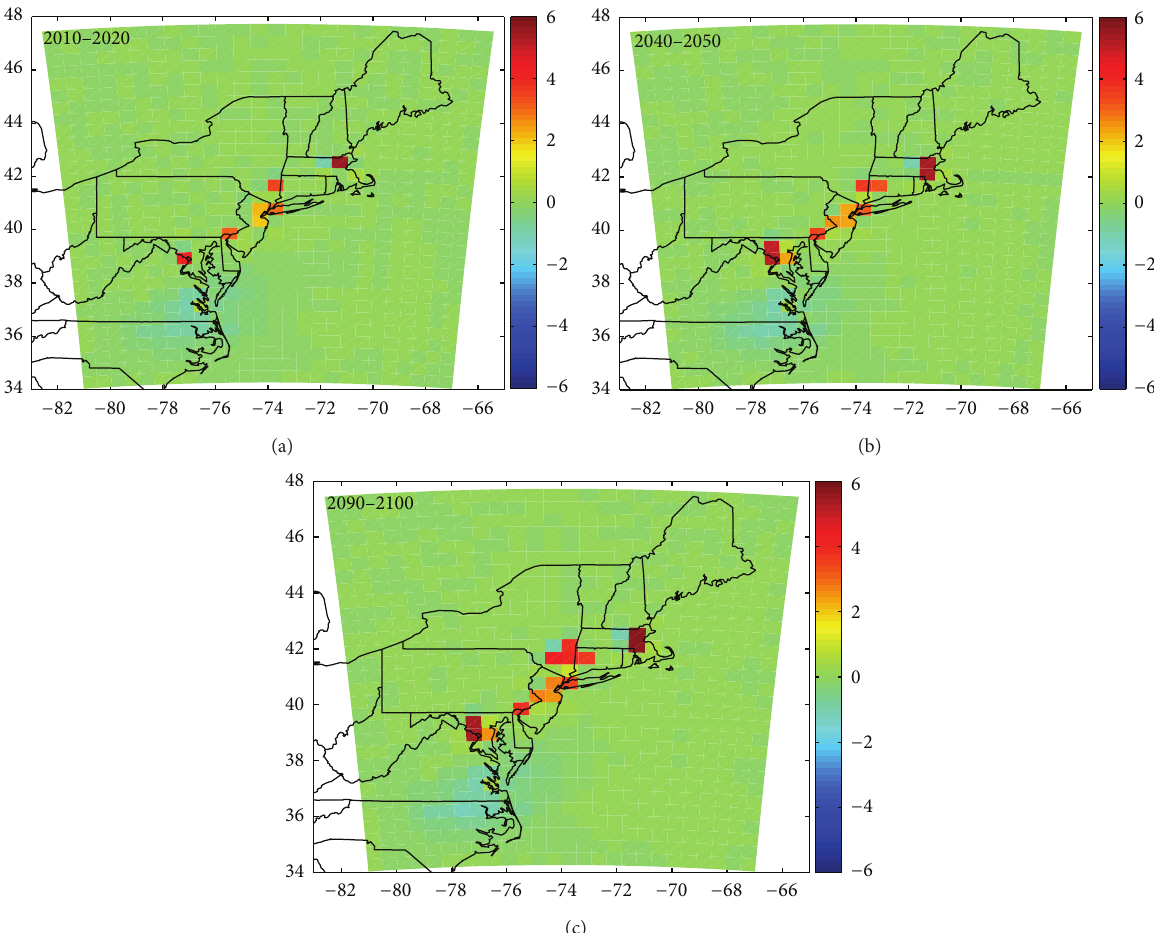
Figure 3: Effects of future urban expansion on average annual temperature in the Northeast megalopolis, USA (unit: ∘